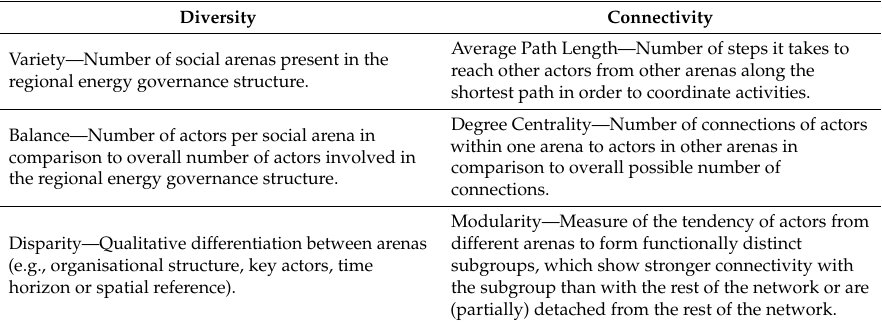
Table 1. Indicators for the social subsystem (based on